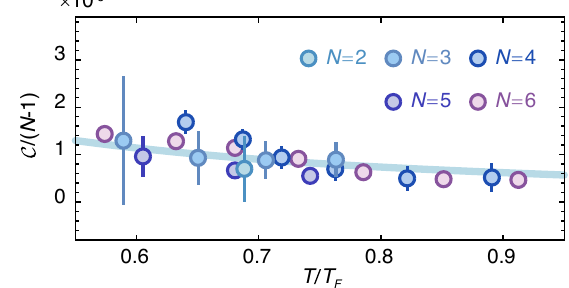
FIG. 8. Scaled contact vs temperature. Contact of different SU ð N Þ gases is scaled on the N ¼ 2 components case by C = ð N − 1 Þ . The solid curve is the theoretical simulation multi- plied by a factor of